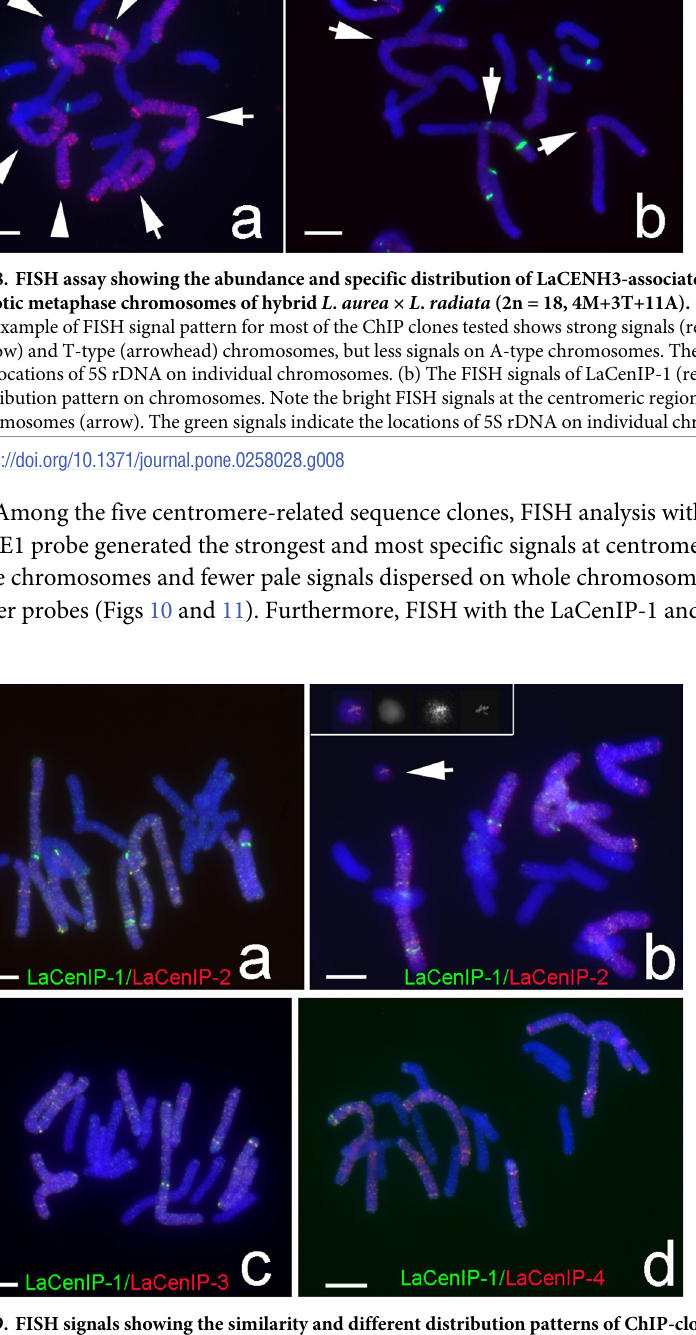
Fig 9. FISH signals showing the similarity and different distribution patterns of ChIP-clones on Lycoris chromosomes. (Scale bar = 10 μ m). (a, b) LaCenIP-1 (green), LaCenIP-2 (red); (c) LaCenIP-1 (green), LaCenIP-3 (red); and (d) LaCenIP-1 (green), LaCenIP-4 (red). The FISH signals in (b) were over enhanced to show signals on the mini-chromosome (arrow). Inset shows enlarged images of that mini-chromosome in each channel: from left to right are merged image, blue signal (DAPI), red signal (LaCenIP-2) and green signal (LaCenIP-1).